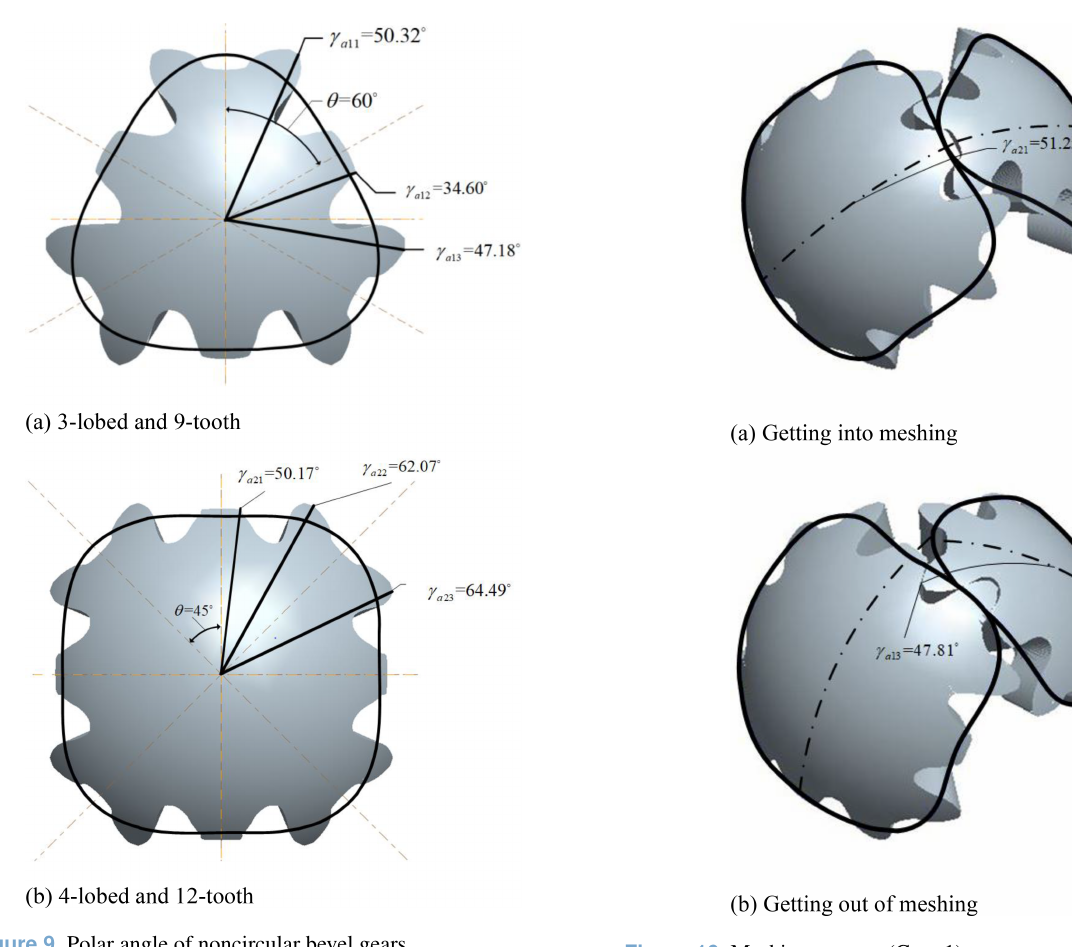
Figure 9. Polar angle of noncircular bevel gears. Figure 10. Meshing process (Case